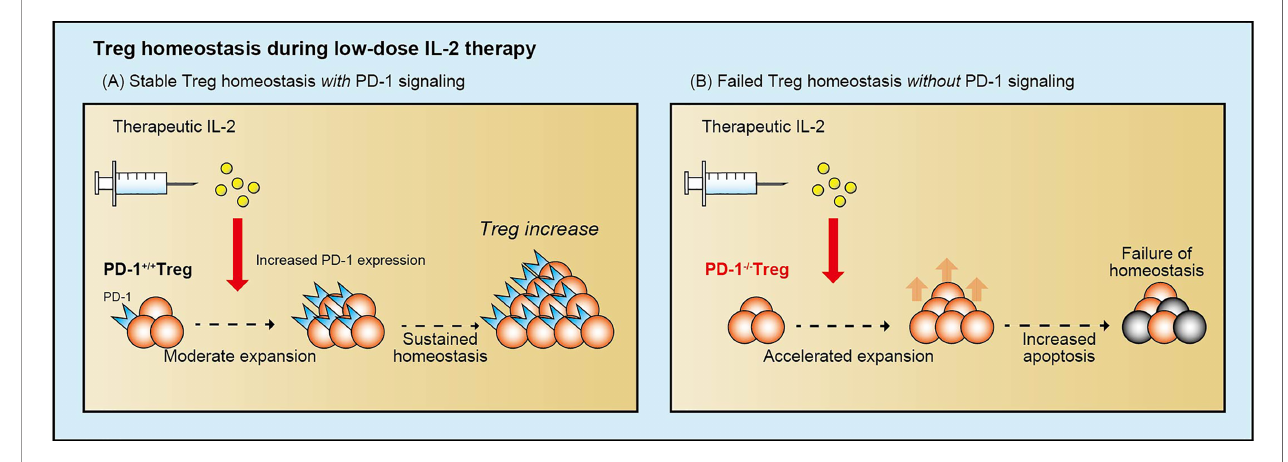
FIGURE 4 | The role of PD-1 in Treg homeostasis during low-dose IL-2 therapy. Low-dose IL-2 therapy increases PD-1 expression on Tregs, and PD-1 preserves sustainable Treg homeostasis during low-dose IL-2 therapy, resulting in the preferential expansion of Tregs and the clinical improvement of chronic GVHD symptoms (A) . In contrast, without suf fi cient PD-1 signaling, low-dose IL-2 therapy accelerates Treg expansion soon after initiation, but Tregs are predisposed to the proapoptotic status and cannot maintain the expansion (B) . IL-2, interleukin 2; PD-1, programmed cell death 1; Treg, regulatory T